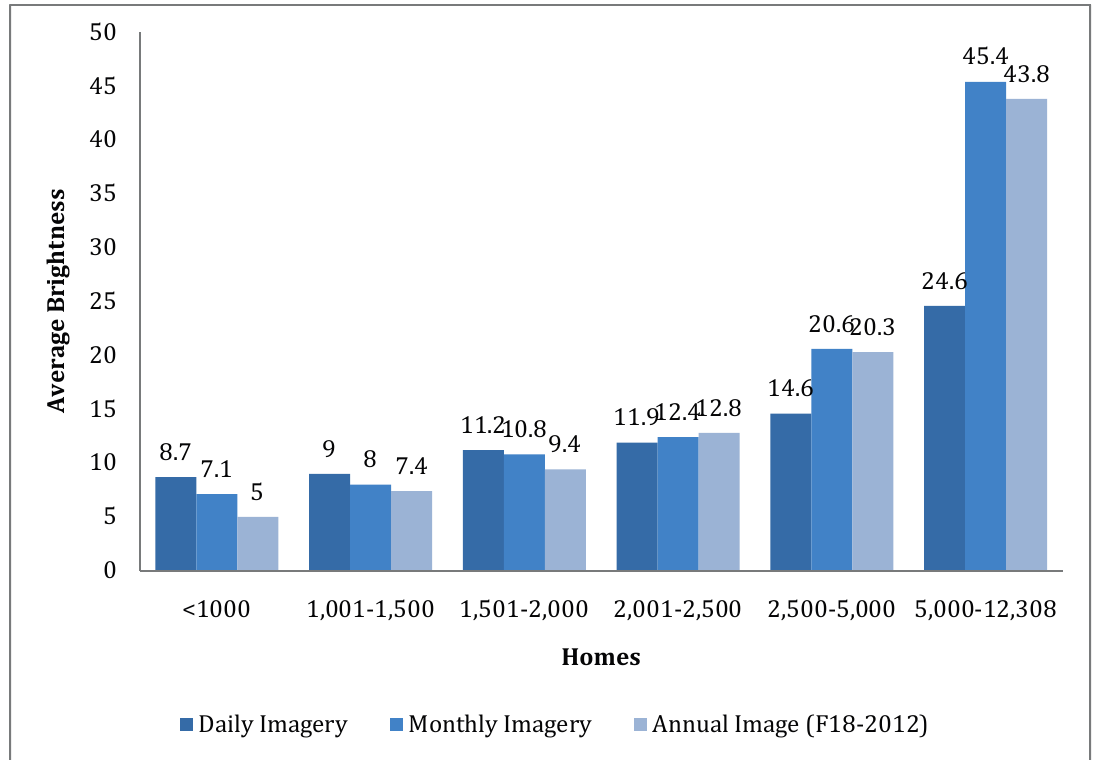
Figure 5. Nighttime light output and electrified